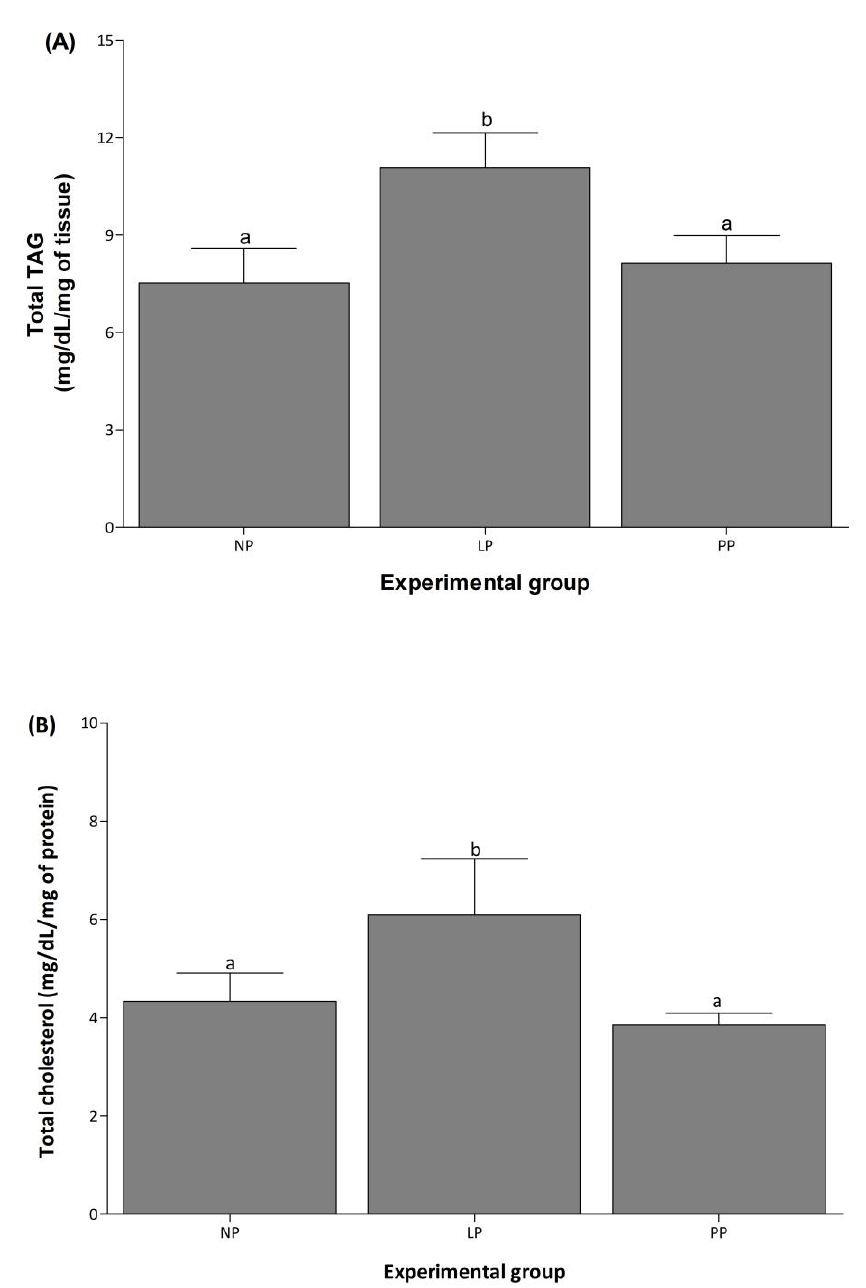
Figure 4. Cardiac total TAG and cholesterol increase during pregnancy. Mean ( ± S.E.M.) of total TAG ( A ) and cholesterol ( B ) contents in left ventricle of non-pregnant (NP, n = 5), late pregnancy (LP, n = 5), and postpartum (PP, n = 5) rats. Different letters indicate significant differences ( p < 0.05) between the NP group and the LP and PP groups.